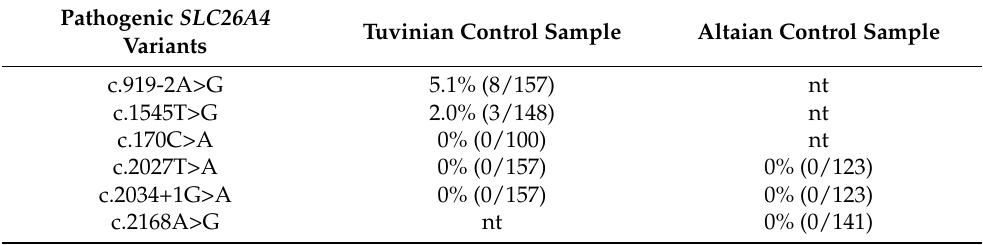
Table 3. The carrier frequency of pathogenic SLC26A4 variants in Tuvinian and Altaian control